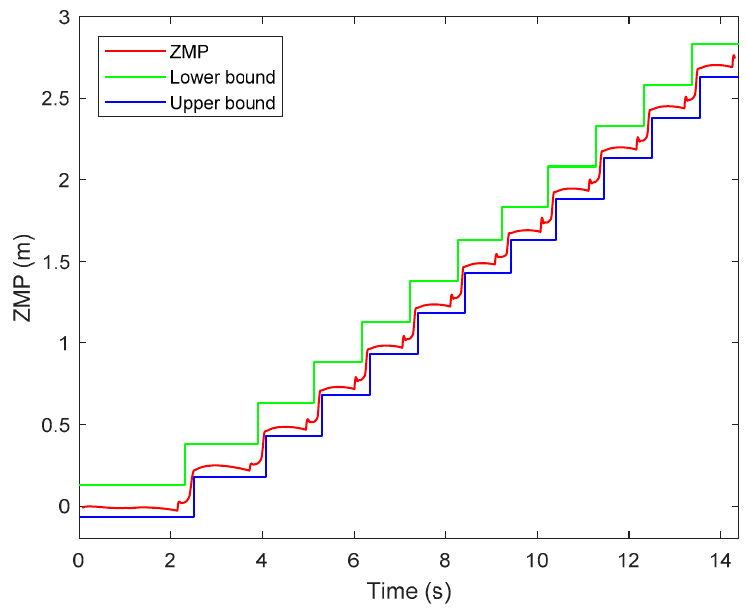
Figure 18. Zero-moment point (ZMP) trajectory in the first simulation.